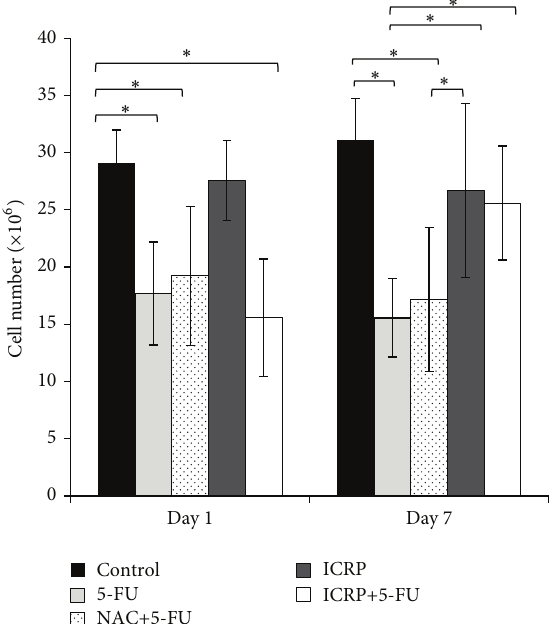
Figure 1: Total bone marrow cell count: BM cells from both femurs and tibias were obtained on day 1 and day 7 from treated mice.